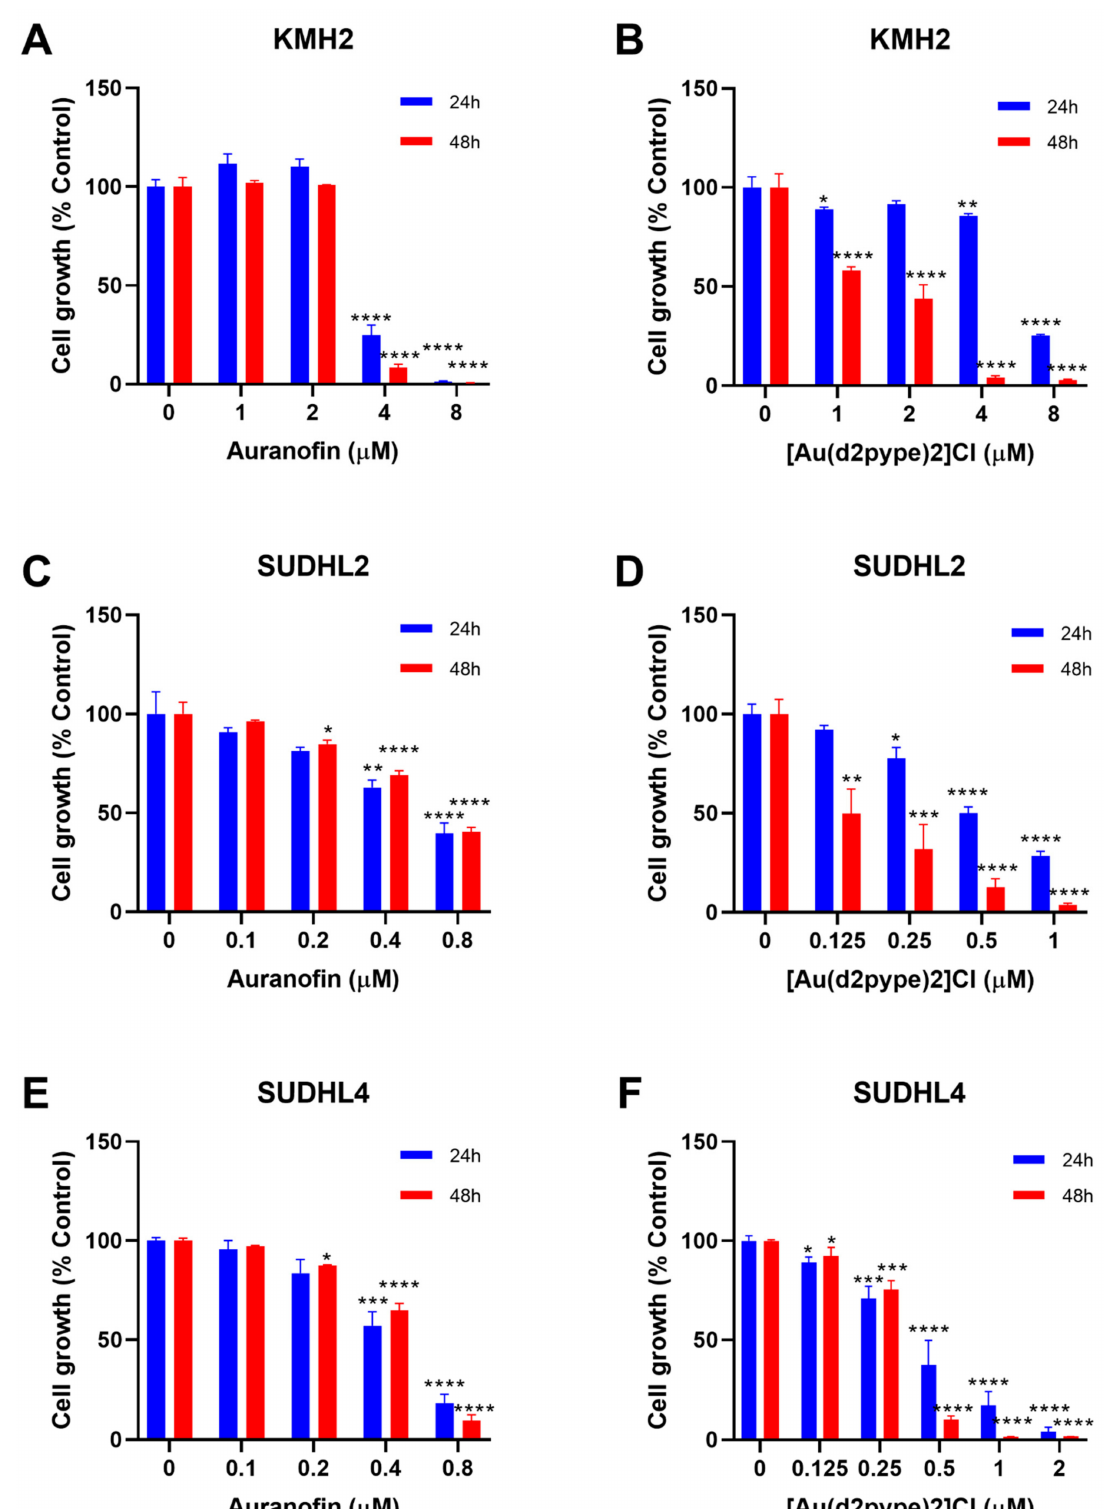
Figure 1. [Au(d2pype)2]Cl and auranofin inhibit lymphoma cell growth in lymphoma cells. ( A ) KMH2, ( C ) SUDHL2, and ( E ) SUDHL4 cells were treated with indicated concentrations of Auranofin for 24 and 48 h. ( B ) KMH2, ( D ) SUDHL2, and ( F ) SUDHL4 cells were treated with different concentrations of [Au(d2pype)2]Cl for 24 and 48 h. Cell growth was detected by MTT assay. Treated cells were compared with the untreated cells. Data were analysed by one-way ANOVA using Dunnett’s post-test. Values indicate mean ± SEM ( n = 3). * p < 0.05, ** p < 0.01, *** p < 0.001, **** p <